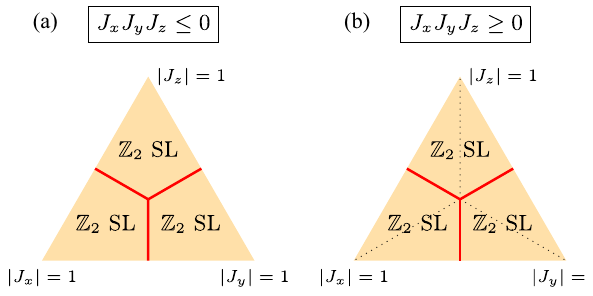
FIG. 9. Emergent dimer liquid in a spin- 3 = 2 model from two- body off-diagonal terms. Complementary to the model in Eq. (15) where deconfinement is stabilized by single-site anyon fluctua- tions in the spin- 3 = 2 honeycomb model, here we consider the case with two-body fluctuations in Eq. (50). The conservation of two plaquette operators allows for a nonlocal duality mapping as in Eq. (53) to the spin-1/ 2 XYZ honeycomb magnet, resulting in the above phase diagrams with extended spin liquids, using 1 . Panel J J barycentric coordinates where j J x j þ j y j þ j z j ¼ ≤ 0 , the ground state always satisfies J J (a) shows that, if J x y z 1 ¼ ˜ G W ; the three Ising phases of the spin-1/ 2 XYZ magnet p ¼ p map to three spin liquids. In panel (b), the phase diagram is very ≥ 0 , except along the black dotted lines, where J J similar for J x y z there is an extensive ground-state degeneracy of the aforemen- tioned plaquette